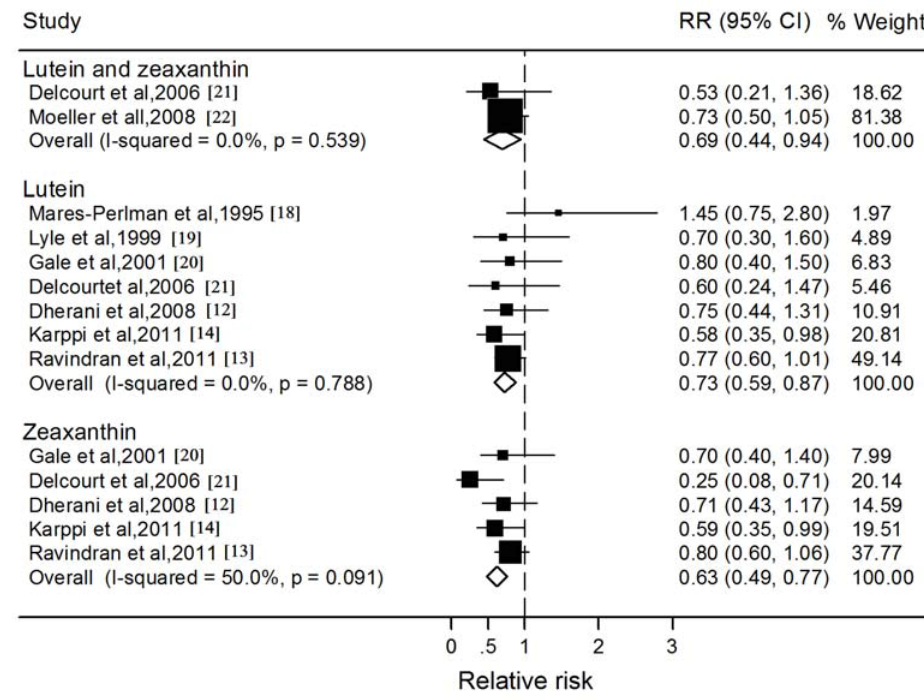
Figure 2. Forest plots of relative risks (RR) and 95% confidence interval (CI) for highest- versus -lowest category of blood concentrations of lutein and zeaxanthin and nuclear cataract risk.